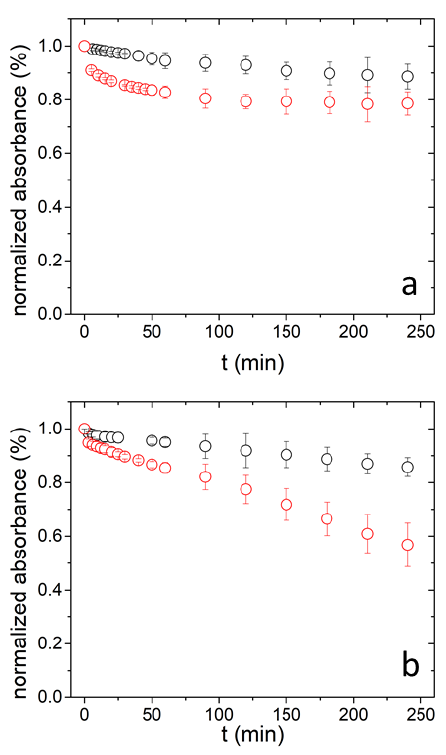
Figure 8. Curcumin’s absorbance at 425 nm in free solution (black) and loaded on xanthan -BSA NPs at pH 5 ( a ) and pH 7 ( b ). Reprinted from [96], copyright 2021, with permission from Elsevier.